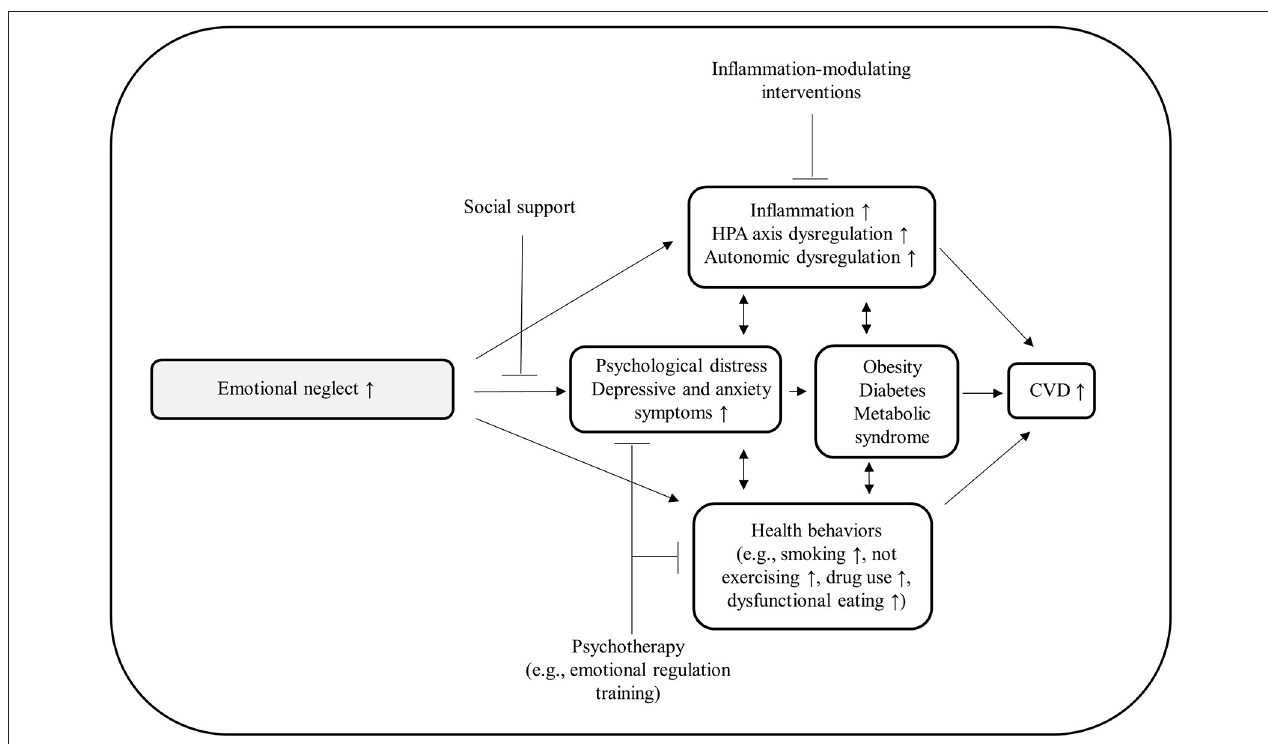
FIGURE 1 | Heuristic model summarizing the associations between emotional neglect and CVD, potential underlying mechanisms, and potential pathways to influence and inhibit pathological processes with psychosocial